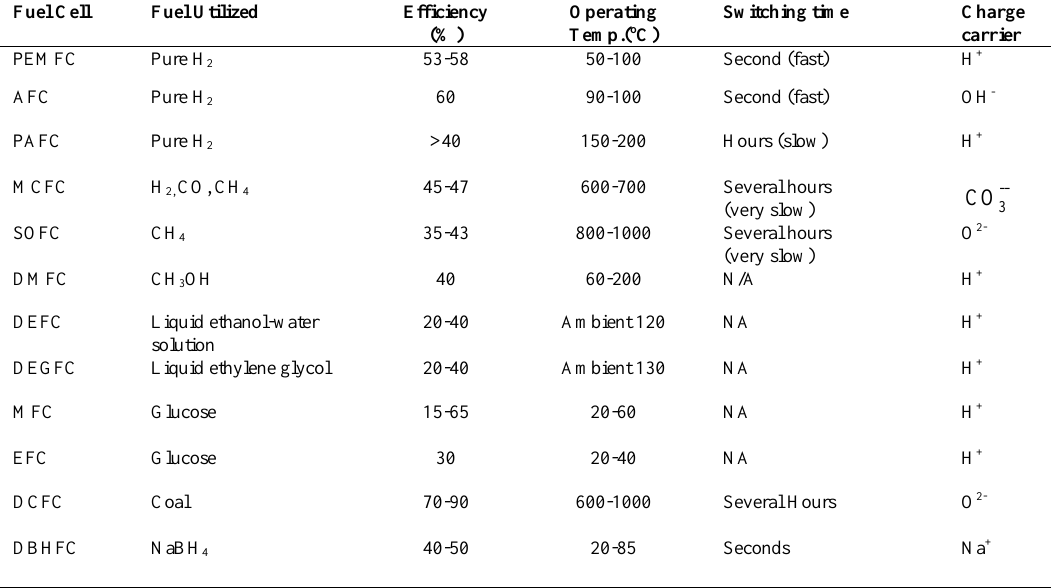
Table 1. Comparisons of FCs with their operation parameters